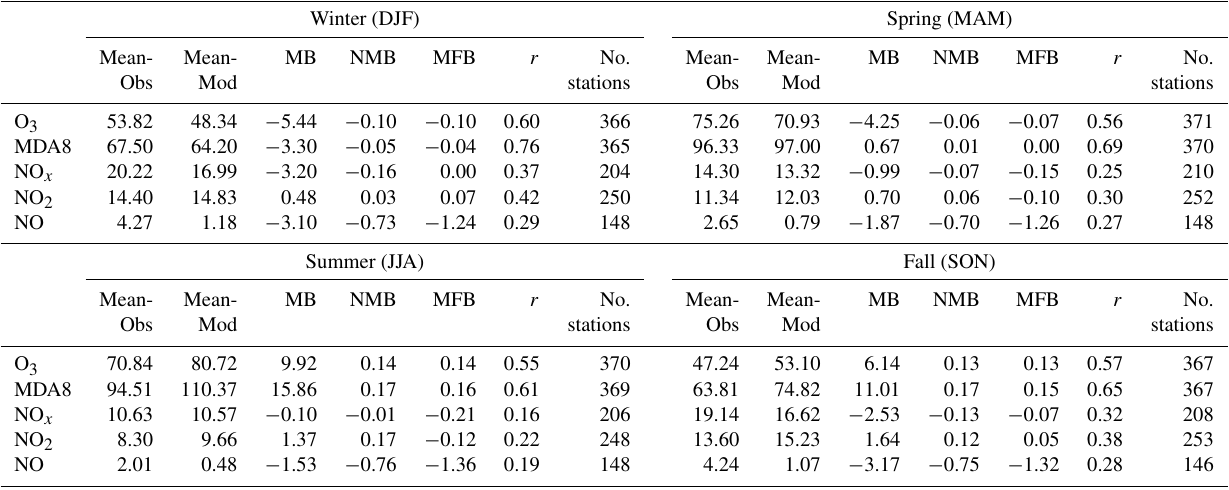
Table 5. Statistics for MOZART simulation against hourly observations from the AirBase network. Means and MB are expressed in µgm − 3 ; NMB, MFB, and r are unitless. r is the hourly temporal correlation coefficient for all quantities except MDA8, for which it represents the daily temporal correlation coefficient.